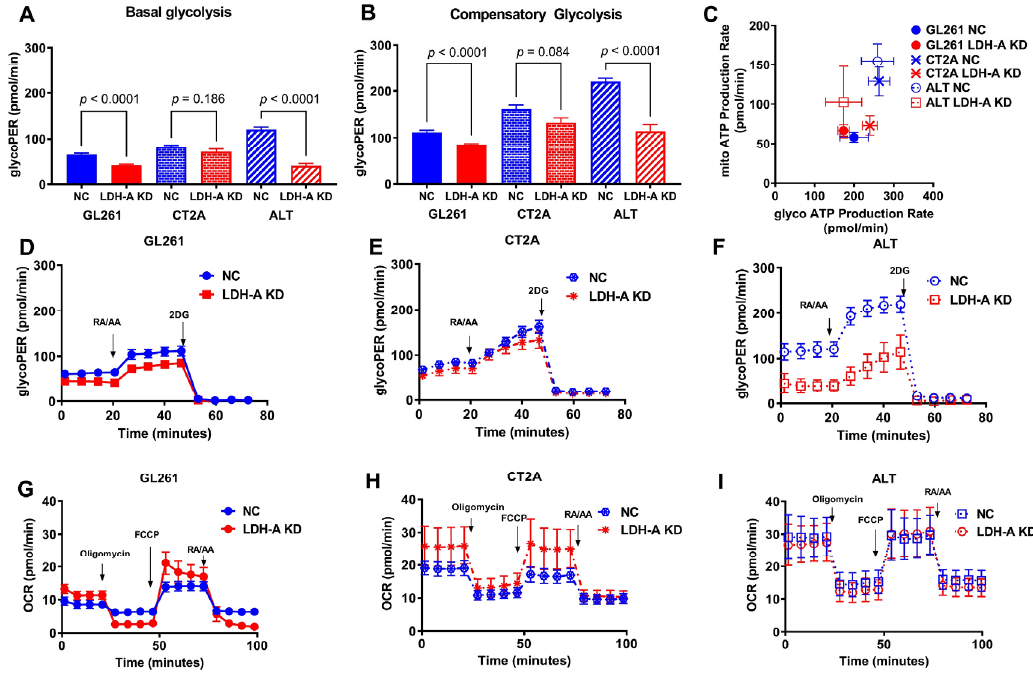
Figure 2. Metabolic energy generation of NC and LDH-A KD murine glioma cell lines . Glycolytic proton efflux rate (glycoPER): basal ( A ) and compensatory glycolysis ( B ) assessed by Seahorse XF analyzer (30,000 of NC and LDH-A KD GL261, CT2A, ALTC1S1 cells were seeded 4 h before the experiments). Results were normalized per 10,000 cells (n = 6, mean ± SEM); Rot/AA, rotenone + antimycin A; 2-DG, 2-Deoxy-D-glucose). Energy map of six tested cell lines charting mitochondrial ATP (mito ATP) versus glycolysis-generated ATP (glycol ATP) production; mean ± SD ( C ). Repre- sentative profiles of real-time glycoPER for GL261 ( D ), CT2A ( E ) and ALTS1C1 ( F ) cell lines, com- paring NC and LDH-A KD. Representative profiles of a real-time OCR profile for GL261 ( G ), CT2A ( H ) and ALTS1C1 ( I ) cell lines, comparing NC and LDH-A KD. Values are mean, ± SEM; n = 5 (GL261); 4 (CT2A); 7 (ALTS1C1). 3.3. Changes in mRNA Expression Levels of Glioma Cells Following LDH-A Knock-Down